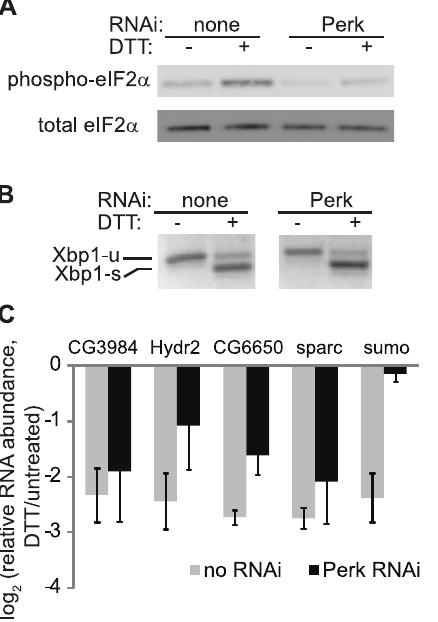
Figure 4. RIDD of sumo is dependent on Perk. We used RNAi to deplete S2 cells of Perk. A. Western blot showing the levels of phosphorylated and total eIF2 a . B. Agarose gel showing the relative levels of unspliced and spliced Xbp1, amplified by reverse-transcription- PCR using primers surrounding the splice site. C. Relative mRNA levels in ER stress treated vs untreated cells, determined by qPCR. Panels A-B show representative data, panel C is the average and SD of 3 independent